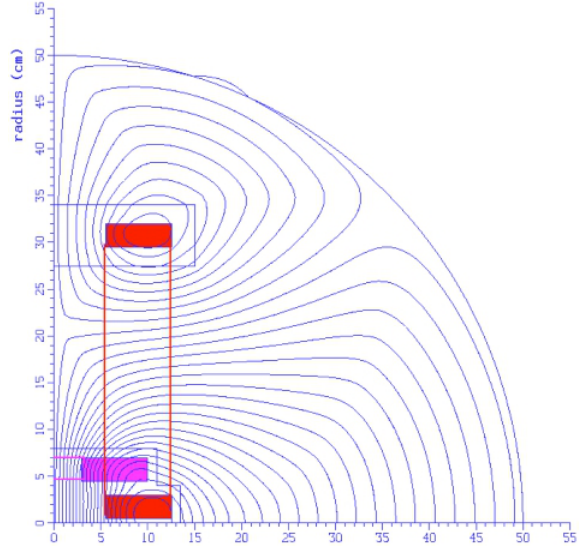
FIG. 55. (Color) Cross section of alternative high field ( (cid:2) 15 T) racetrack coil dipole magnet with Nb 3 Sn conductor.